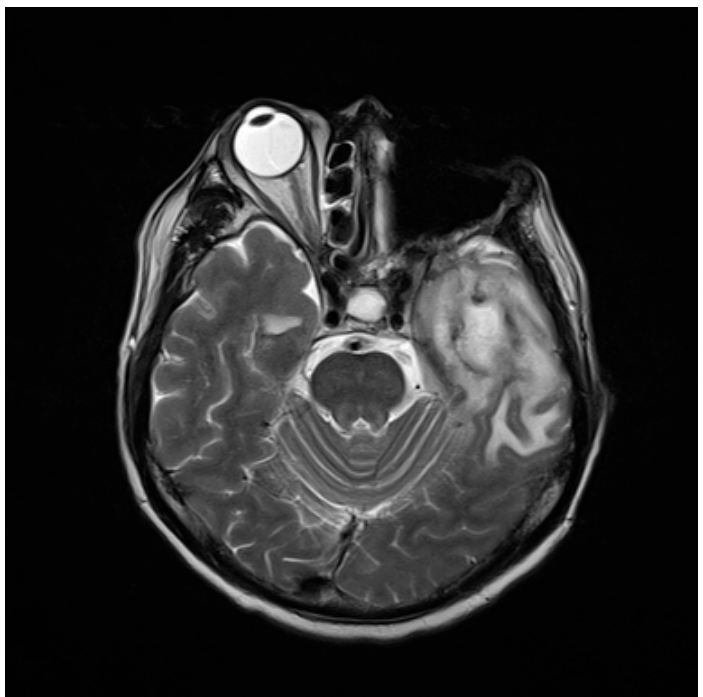
Figure 1. Magnetic resonance image (MRI) of brain showing heterogeneous enhancement with focal rim enhancing cystic lesions in left anterior temporal lobe.